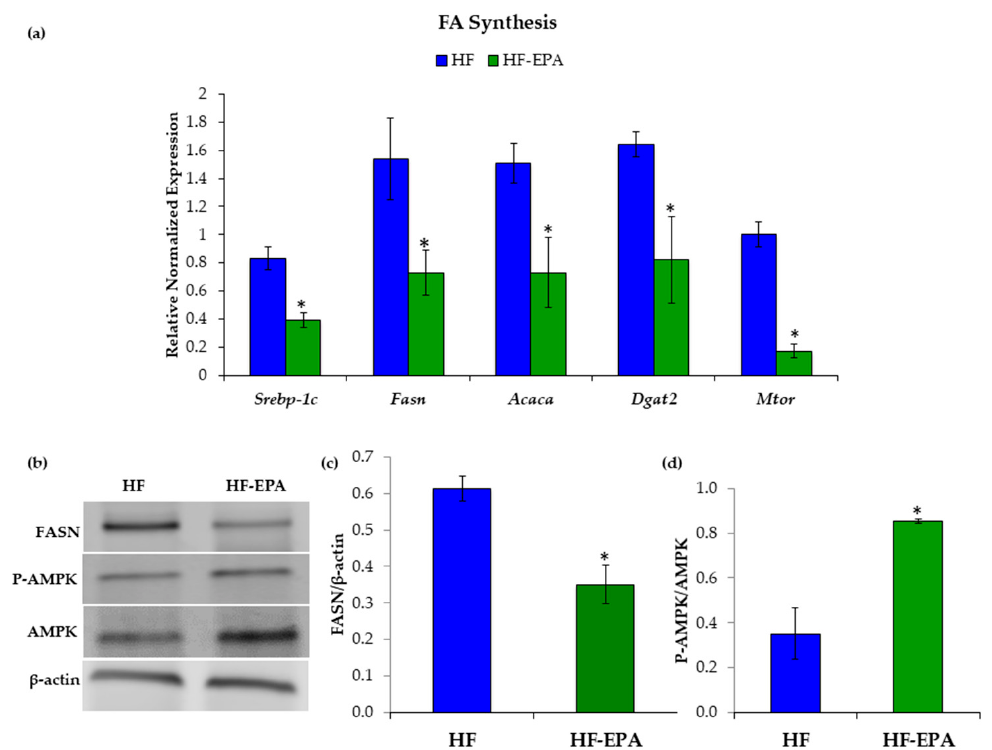
Figure 2. Eicosapentaenoic acid (EPA) supplementation reduces hepatic fatty acid (FA) synthesis. ( a ) Gene expression studies indicate significantly decreased markers of FA